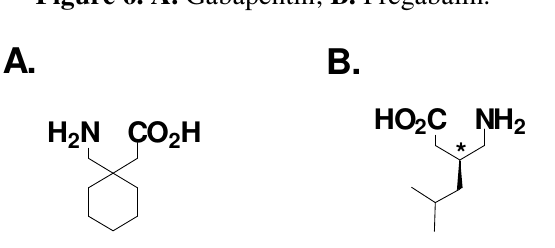
Figure 6. A. Gabapentin; B.